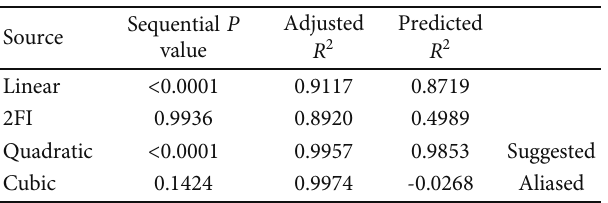
Table 6: Model development for the removal of Pb(II) ions chemically modi fi ed neem